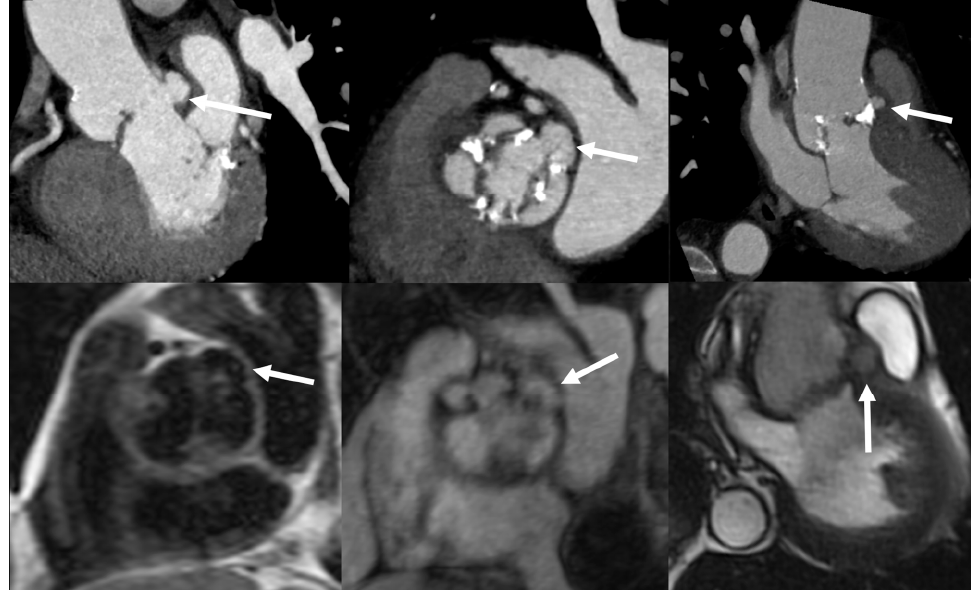
Figure 4. Paravalvular abscesses. CCTA (top images) multiplanar reconstructions and Cardiovascular Magnetic Resonance (CMR) images (bottom images: T1-weighted Turbo Spin Echo on the left, contrast-enhanced T1- weighted Gradient Echo 3D image in the middle and cine-CMR on the right) show a diffuse, partially calcified, thickening of the aortic valve leaflets in a 58-year-old man with Staphilococcus aureus IE and bicuspid valve. IE was complicated by the formation of small perivalvular abscesses, which, following the opening of their contents in the lumen, appear as little saccular outpouchings (arrows).